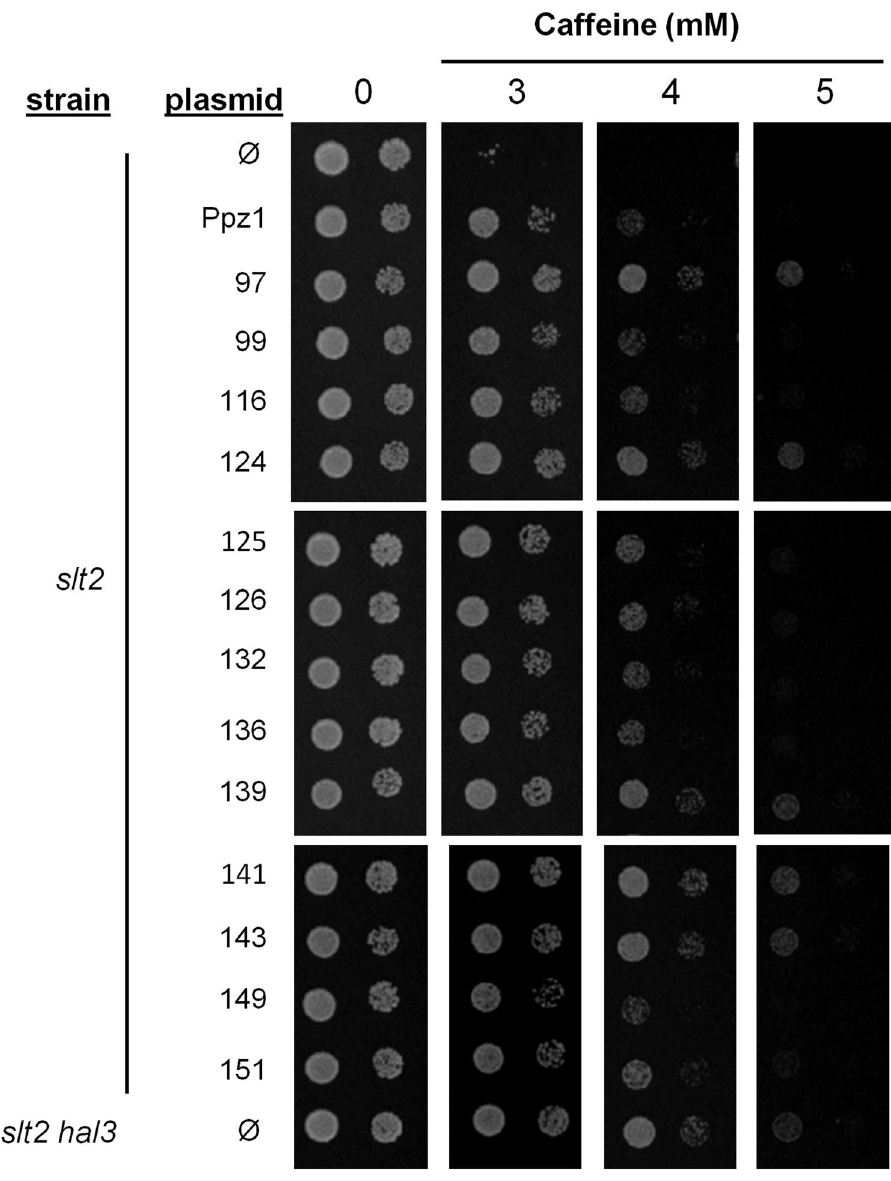
Figure 1. Growth on caffeine plates of selected Ppz1 clones carrying single amino acid mutations. The indicated strains were transformed with pRS316-based plasmids (centromeric, URA3 marker) carrying the indicated versions of Ppz1. Cultures were spotted at OD 660 = 0.05 and at 1/10 dilution, and plates were grown for 72 h. Ø, empty